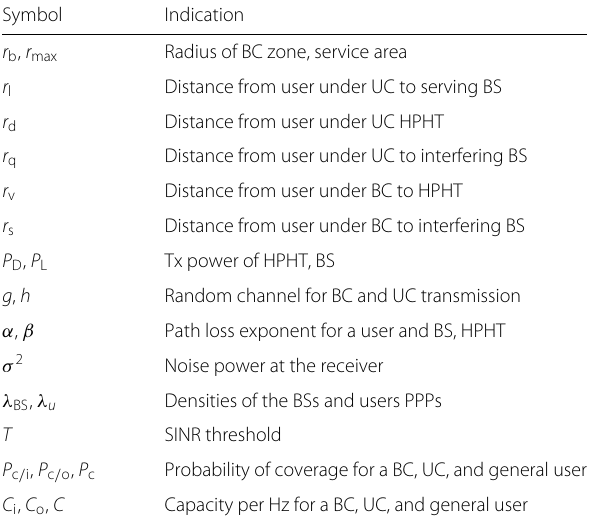
Table 1 Table of used